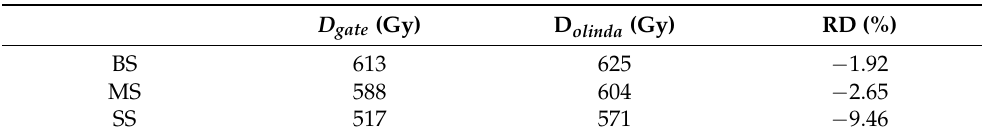
Table 6. Mean absorbed dose values for each sphere, calculated from the Gate image ( D gate ) with a reduced workflow and from the application of the OLINDA/EXM factors ( D olinda ). The relative − D olinda difference (RD) is defined as RD = D gate . D olinda D gate (Gy) D olinda (Gy) RD (%) BS 613 625 − 1.92 MS 588